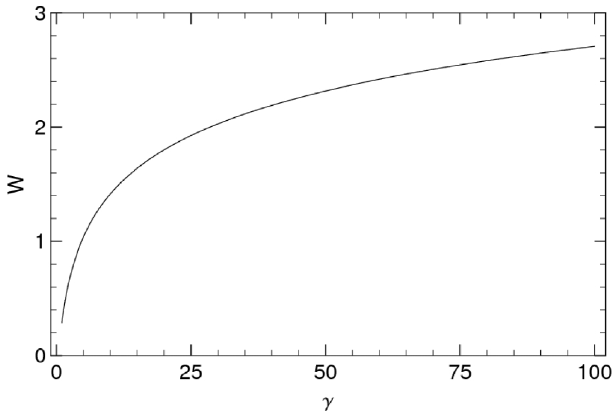
FIG. 2. Integrated electromagnetic energy density in units Q 2 =(cid:4) for a spherical Gaussian bunch as a function of (cid:1)